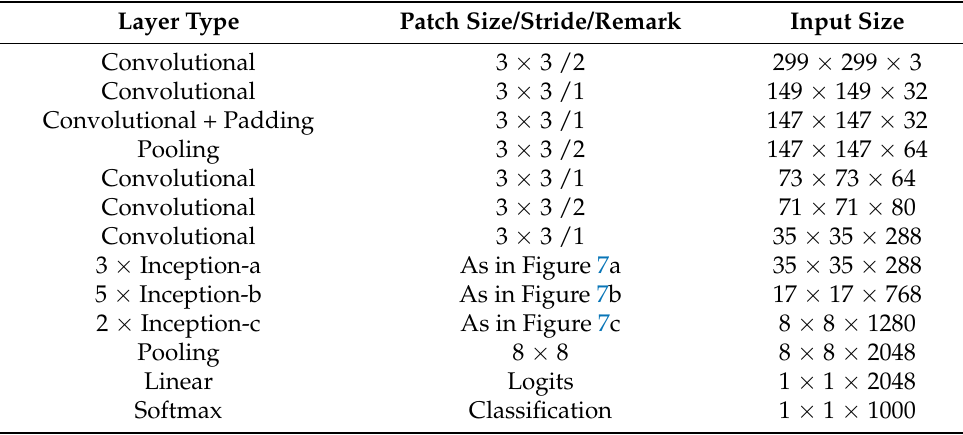
Figure 7. Block schemes of Inception modules ( a ) Inception-a; ( b ) Inception-b; and ( c ) Inception-c. Table 4. Layer configuration of an InceptionV3